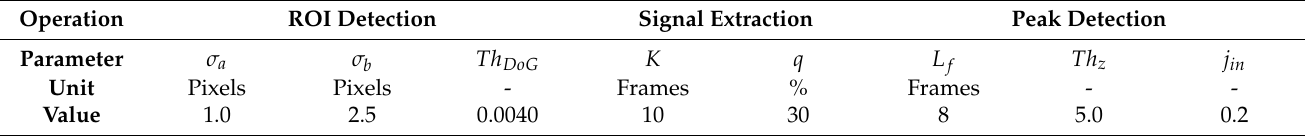
Table 3. The parameters used to visualize early calcium activity of hiPSCNs in dataset 2.